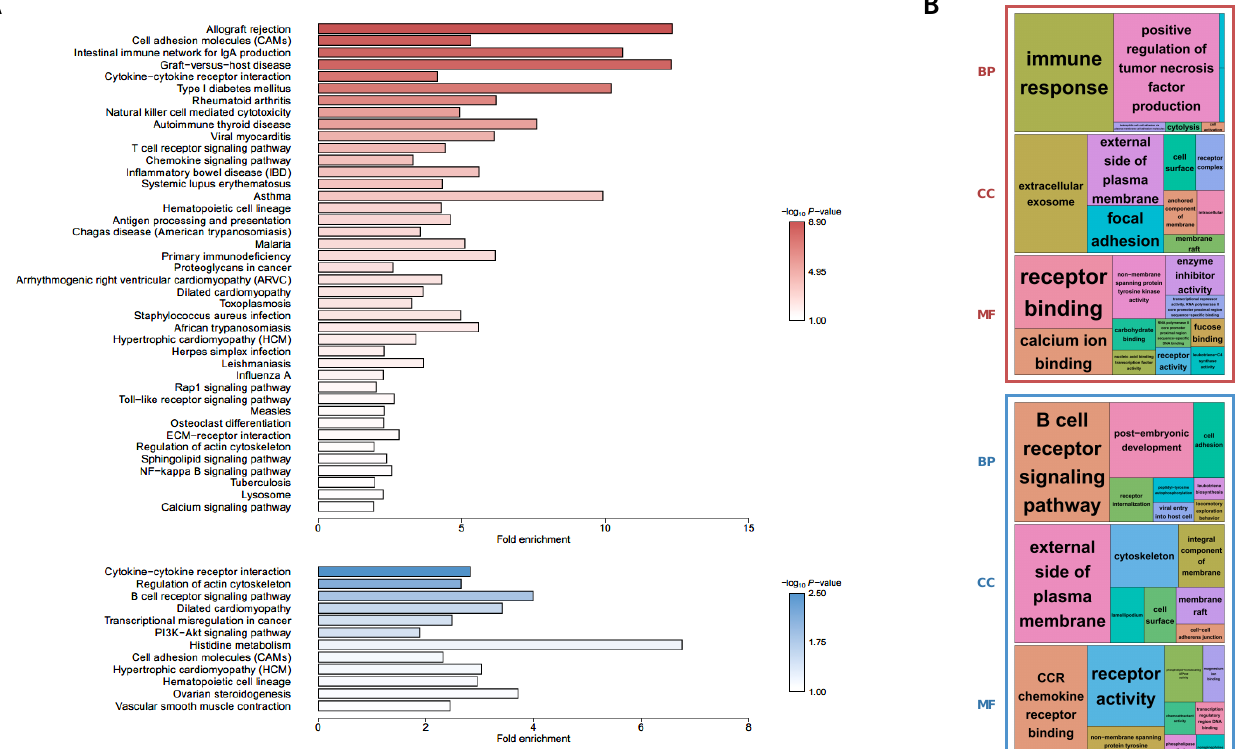
Figure 2. Enrichment analyses based on the DAVID database, aimed at discovering the biological meaning of common up- (red) and down-regulated genes (blue) between D10 CD8 + vs. D10 CD8 − and D28 CD8 + vs. D28 CD8 − : ( A ) KEGG-enriched pathways were visualized by bar plots; ( B ) GO treemaps (biological process: BP, cellular component: CC, and molecular function: MF) were made based on the p